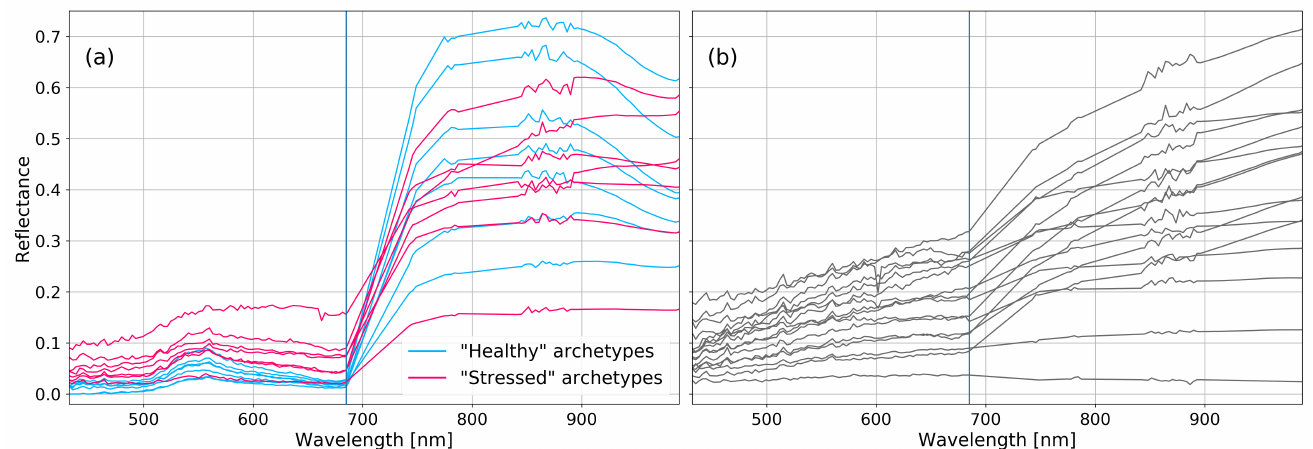
Figure 4. Classified archetypical reflectance spectra from the research site “Am Grossen Bruch” (DE-GsB). ( a ) Archetypes classified as “healthy” or “stressed”. ( b ) All of the non-vegetation spectra were classified as “background”. The vertical blue line marks the beginning of the red edge slope at 685